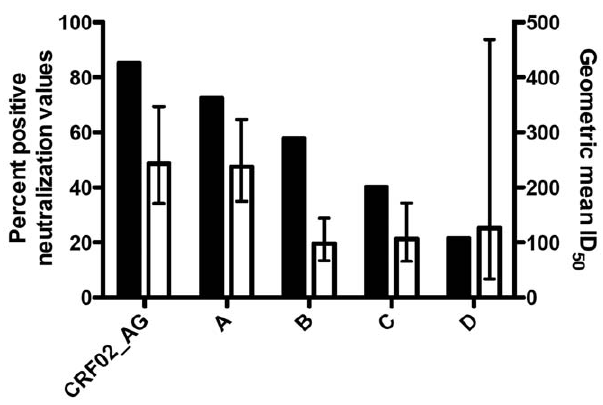
Figure 5. Patients infected with HIV-1 subtype A show greater frequency and magnitude of neutralization against subype A and CRF02_AG viruses. Sera from 50 HIV-1 subtype A-infected patients were tested in the TZM-bl neutralization assay against 1–3 pseudoviruses of each subtype indicated. The frequency of neutraliza- tion (% of titers . 10) of viruses in a given subtype (black bars), as well as the geometric mean titer (ID 50 , white bars) against each viral subtype, is shown. For the geometric mean titers, the error bars represent the 95% confidence intervals.